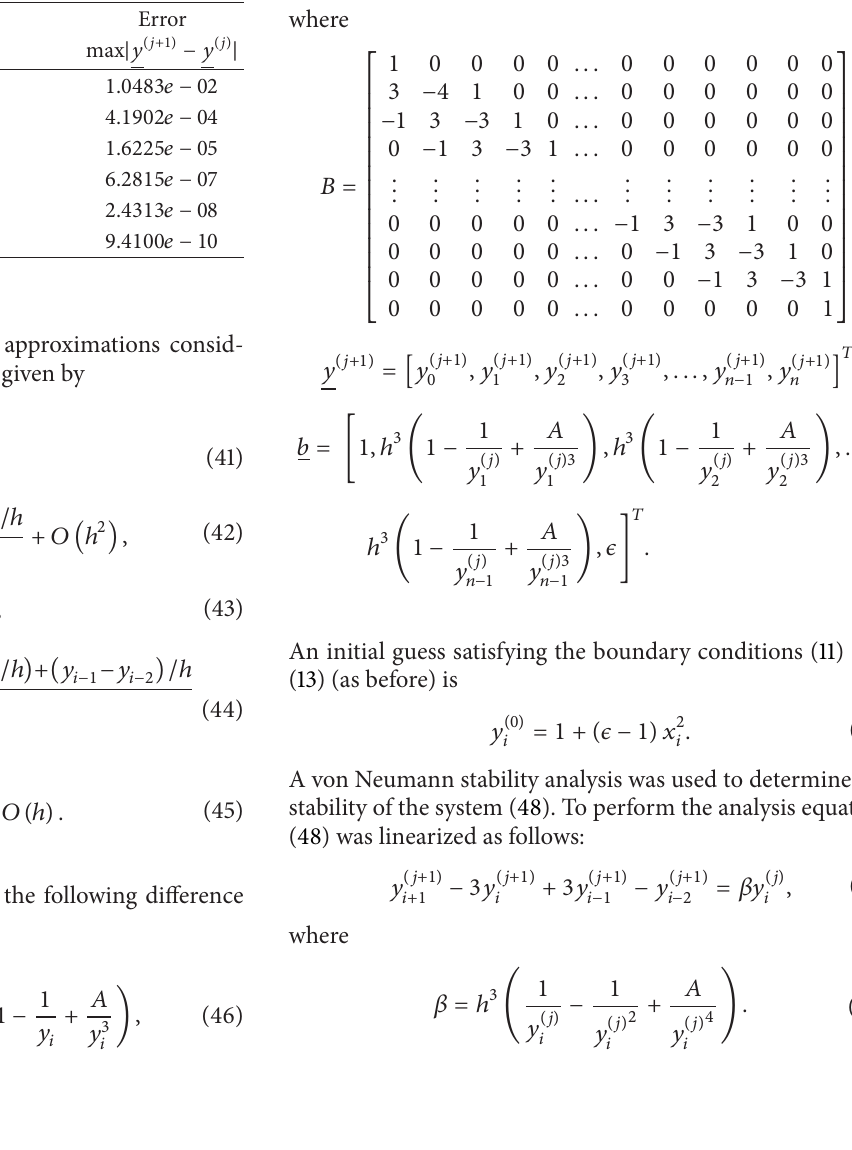
Figure 3: Solution to the symmetric difference scheme for 𝑛 = 100 . Table2:Tableshowingtheabsoluteerroraftereachiterationof (50), where 𝑛 = 100